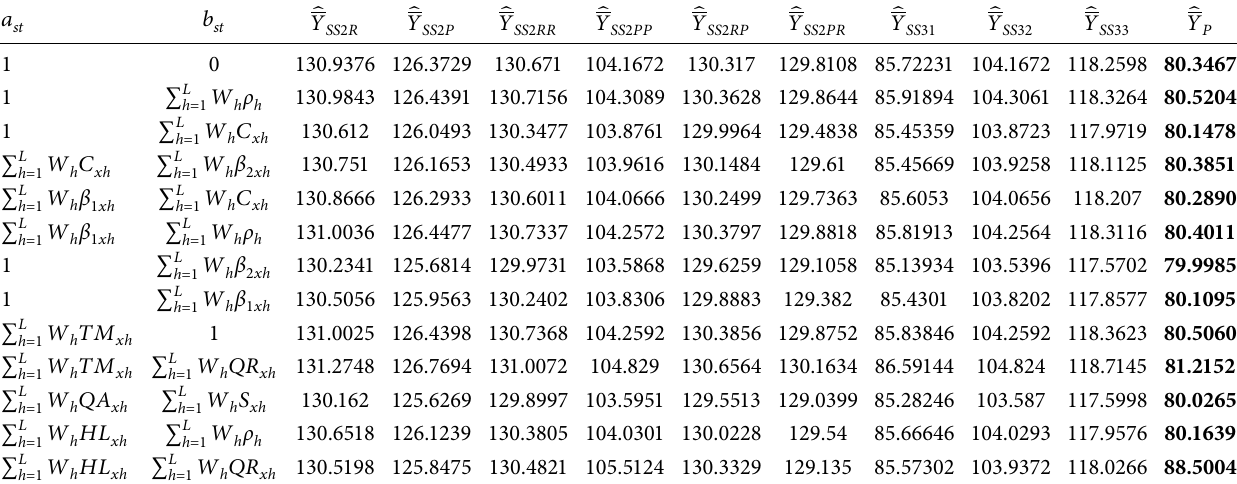
Table 9: Minimum MSEs of different estimators based on the simulation study ( n � 250).